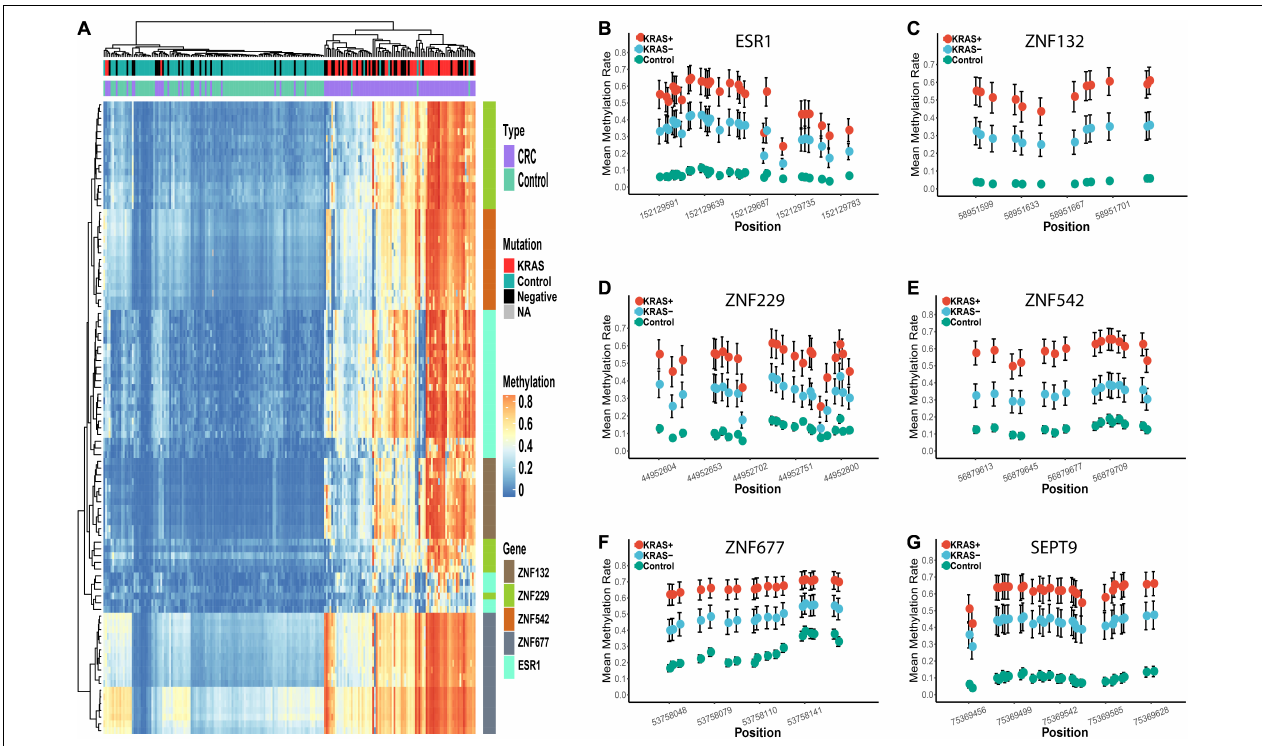
FIGURE 5 | Differential methylation profiles of these candidate biomarkers in KRAS + and KRAS- subgroup in replication cohort 2. Panel (A) represents the heatmap of the methylation levels of these five candidate genes. The tumor and para-tumors were differently colored. The KRAS mutation status of the CRC tumors is also differently colored. Panels (B–G) represents the methylation profiles of the five zinc finger genes and SEPT9. The mean methylation percentage of each CpG site is shown for KRAS +, KRAS- and control groups.